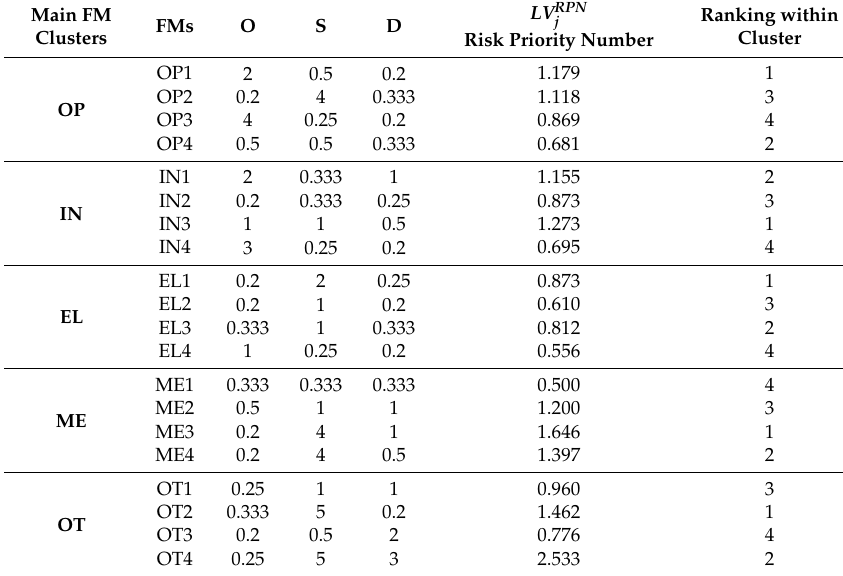
Table 4. Risk priority number for